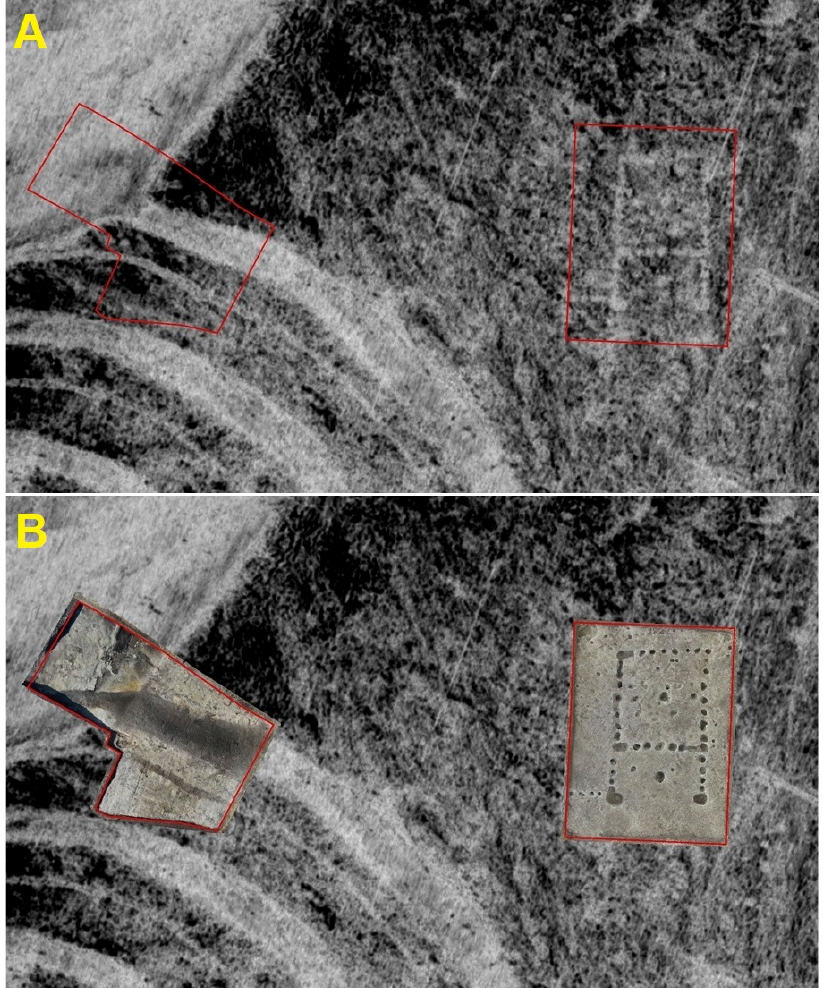
Figure 10. ( A ) Visualization of the GPR dataset (depth range 60–140 cm) with the locations of the two excavation trenches (red frames). ( B ) The two orthophotos of the excavation trenches placed over the GPR dataset, showing perfectly coinciding investigation methods.